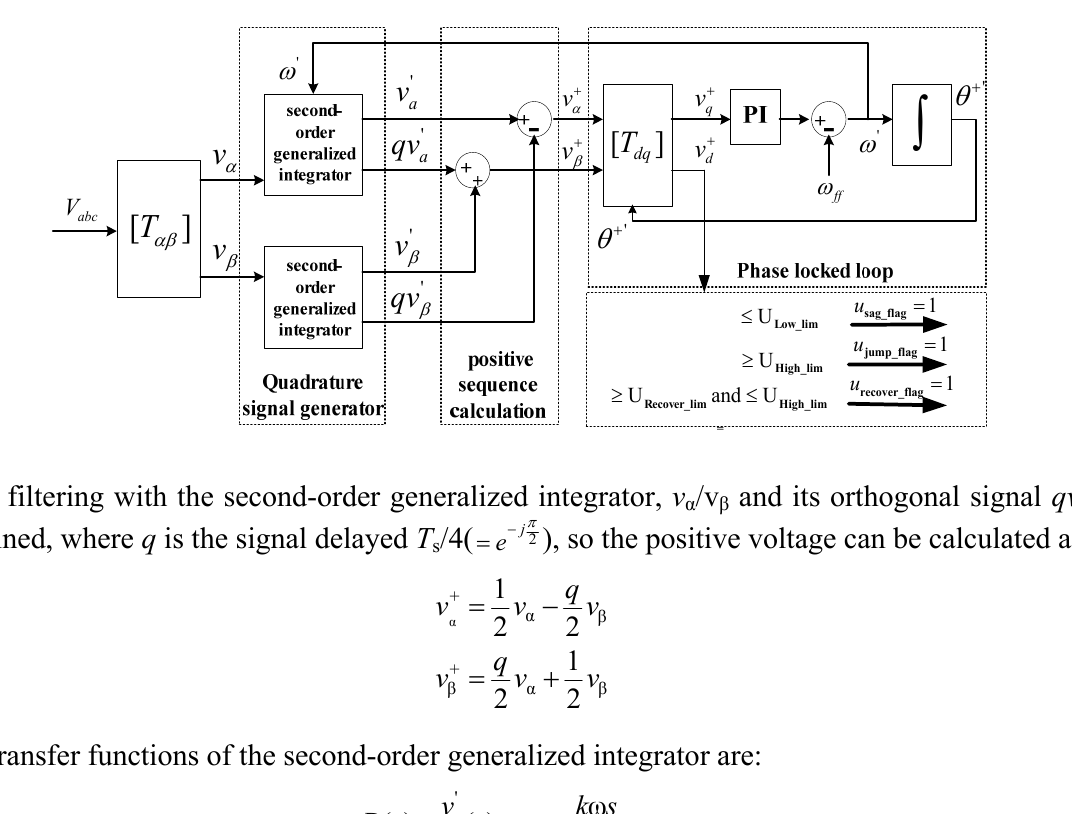
Figure 7. Scheme of grid fault detection